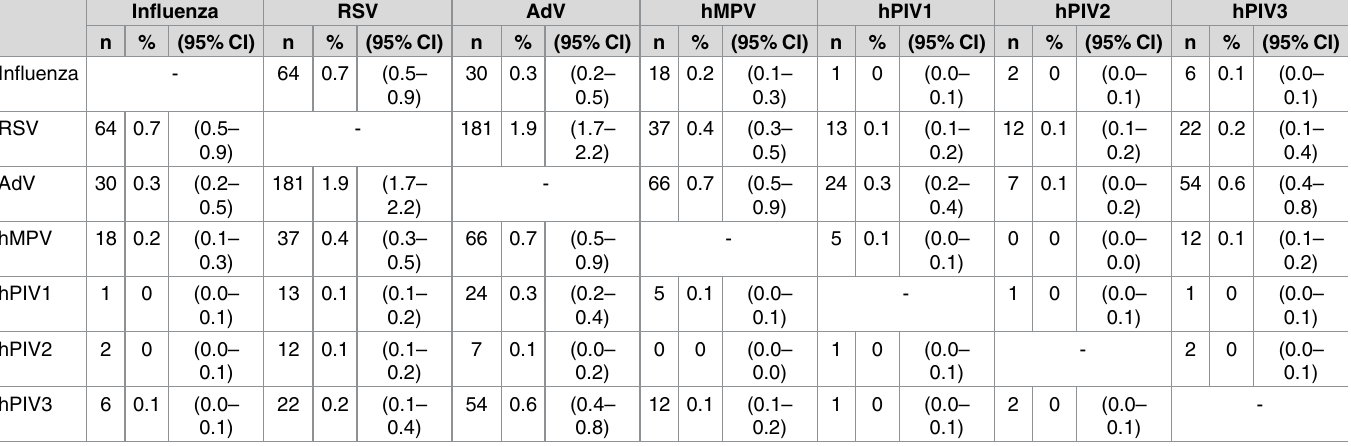
Table 2. Coinfections by viral respiratorypathogen (n = 501). Includes5 patients with influenza,RSV and AdV; 3 with influenza,RSV and hMPV; 3 with RSV, AdV and hMPV; 3 with RSV, AdV and hPIV1; 2 with RSV, AdV and hPIV3; 2 with AdV, hMPV and hPIV3; 1 with influenza,AdV and hMPV; 1 with RSV, AdV and hPIV2; 1 with RSV, hPIV1 and hPIV2; 1 with influenza, RSV, AdV and hMPV; 1 with RSV, AdV, hMPV and hPIV3; 1 with RSV, AdV, hPIV1 and